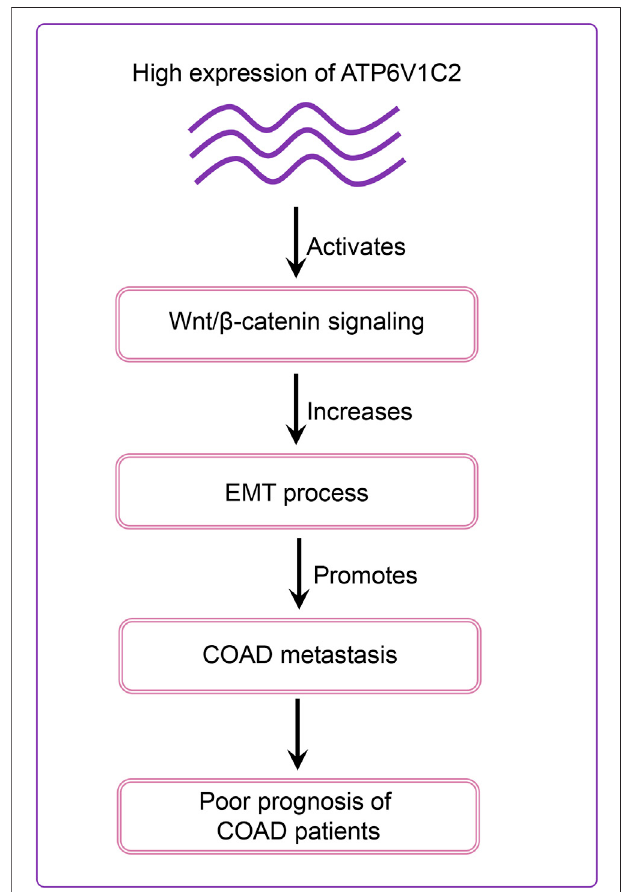
FIGURE 8 | Schematic diagram of ATP6V1C2 expression on the prognosis of COAD patients. ATP6V1C2 overexpression might promote EMT cellular process by activating Wnt signaling pathway, resulting in cancer metastasis and unfavorable prognosis for COAD patients. COAD: colon adenocarcinoma; EMT: epithelial – mesenchymal